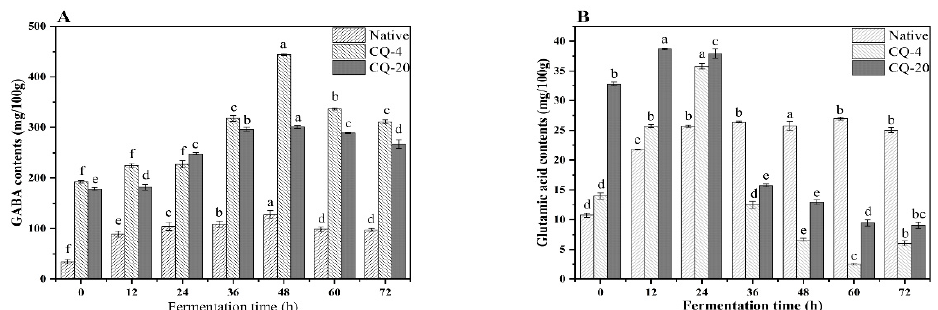
Figure 2. Effect of fermentation with cold stress at 4 °C and − 20 °C on the GABA contents ( A ) and glutamic acid contents ( B ). GABA: γ -aminobutyric acid; Native: native quinoa flour; CQ − 4: quinoa flour cold stress treated at 4 °C; CQ − 20: quinoa flour cold stress treated at − 20 °C. Different lowercase letters indicate significant differences ( p < 0.05) between the same sample group (Native, CQ − 4, CQ − 20).